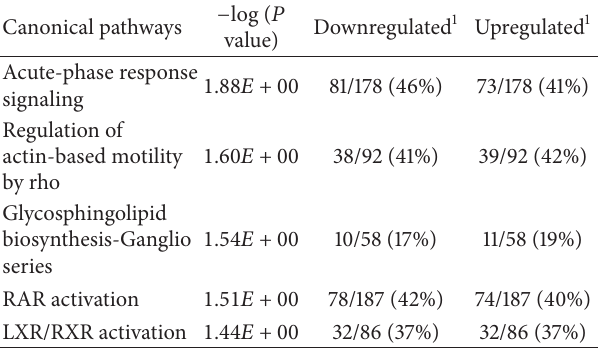
Table 3: Top canonical pathways (FDR = 0.2, 𝑃 < 0.001 , and fold change > 1.5) from IPA analysis of DEG in mammary tissue of lactating mice fed trans -10, cis